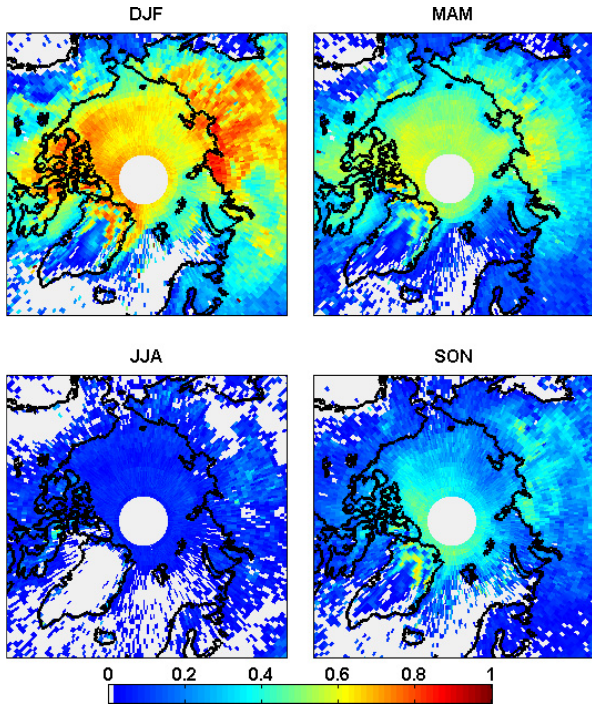
Fig. 3. Seasonal mean frequency of occurrence of WV inversions. The data from 2002–2010 for both ascending and descending over- passes are used for the analysis.